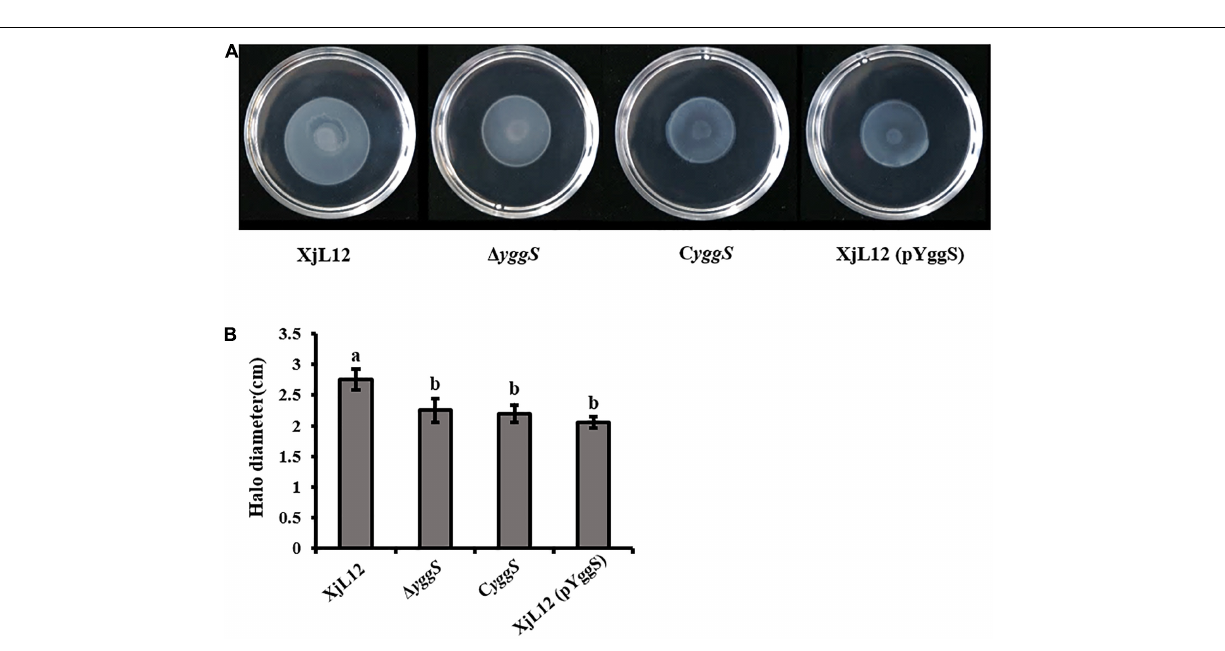
Frontiers in Microbiology |